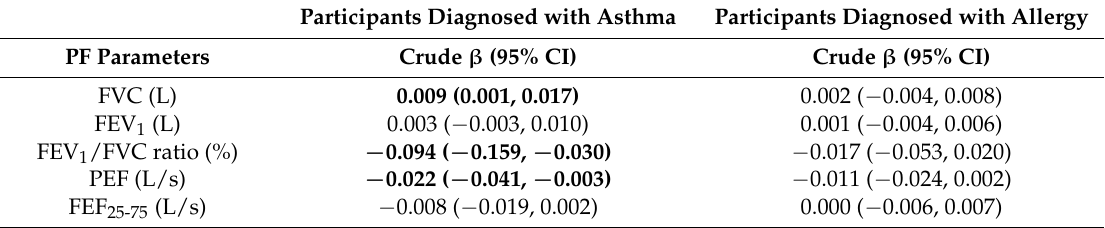
Table 6. Association of serum 25(OH)D concentration (nmol/L) with pulmonary function (PF) parameters in participants diagnosed with asthma ( n 69) and in participants diagnosed with allergy ( n 164). Participants Diagnosed with Asthma Participants Diagnosed with Allergy PF Parameters Crude β (95% CI) Crude β (95% CI) FVC (L) 0.009 (0.001, 0.017)